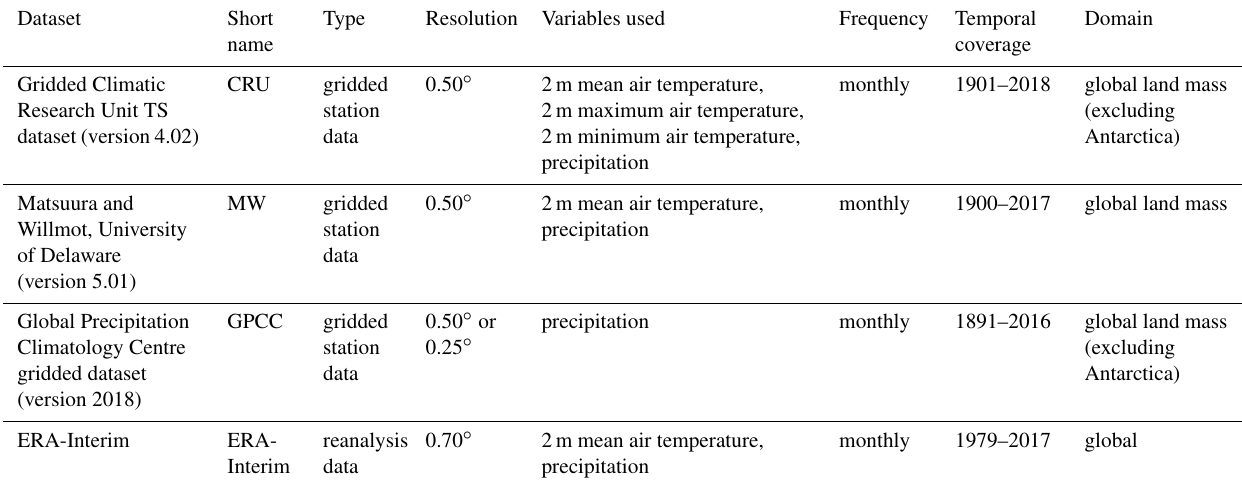
Table 1. Overview of the reference datasets used.